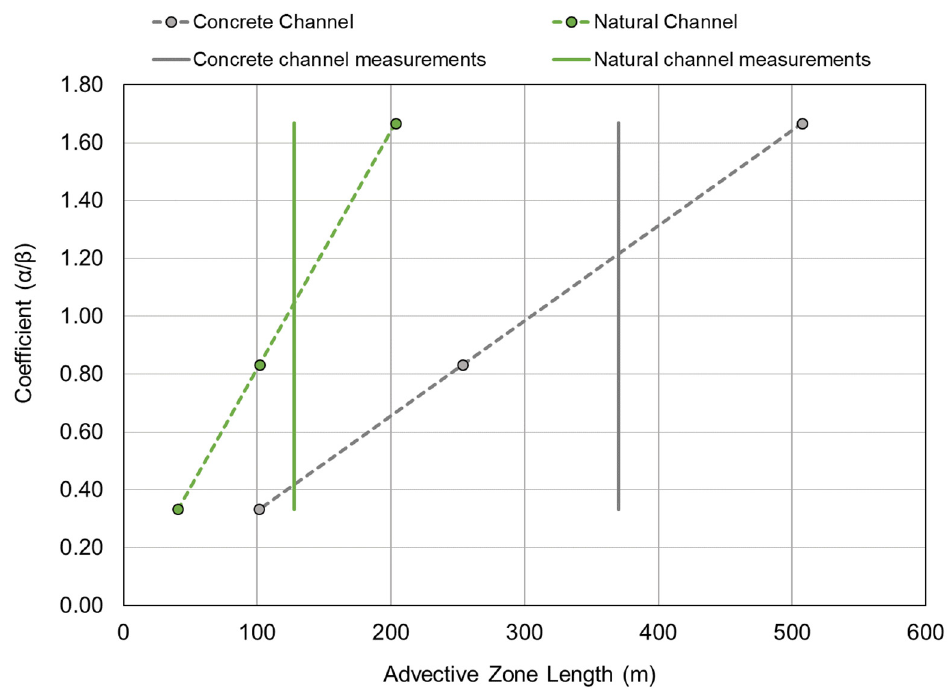
Figure A1. Advective zone length estimates based on the α / β coefficient range and location of farthest downstream measurements in the concrete (grey) and natural (green) channels.